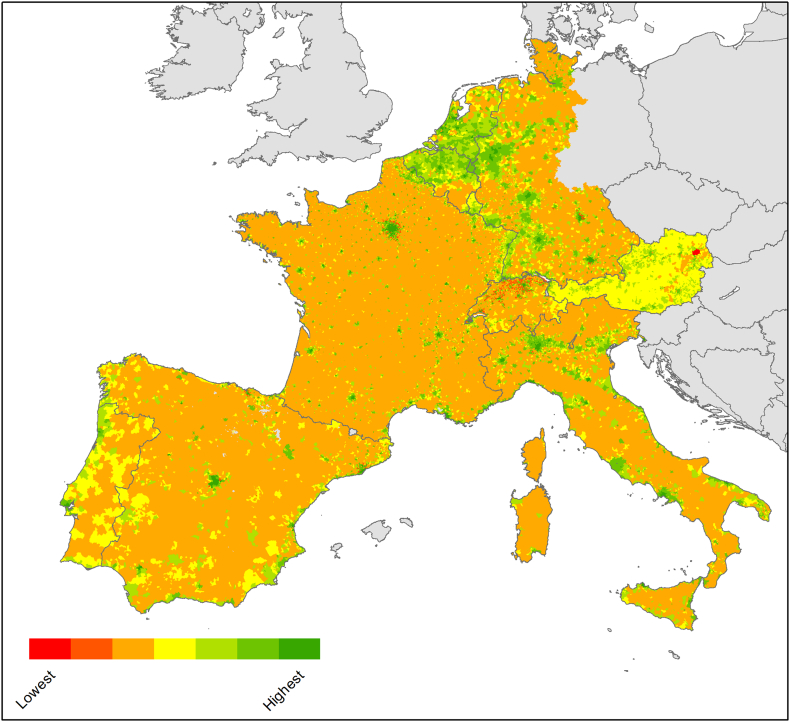
Municipal fixed effects estimated in the model presented in Section 4.